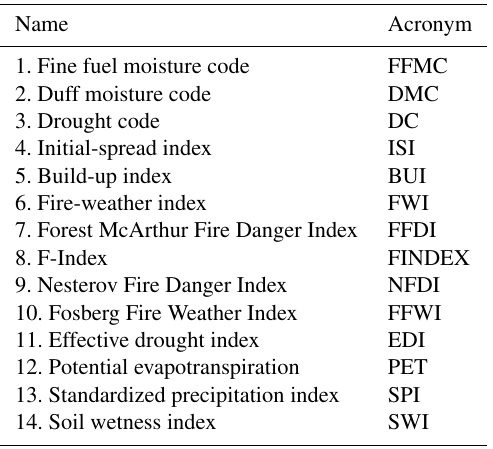
Table 1. Candidate variables in the modeling